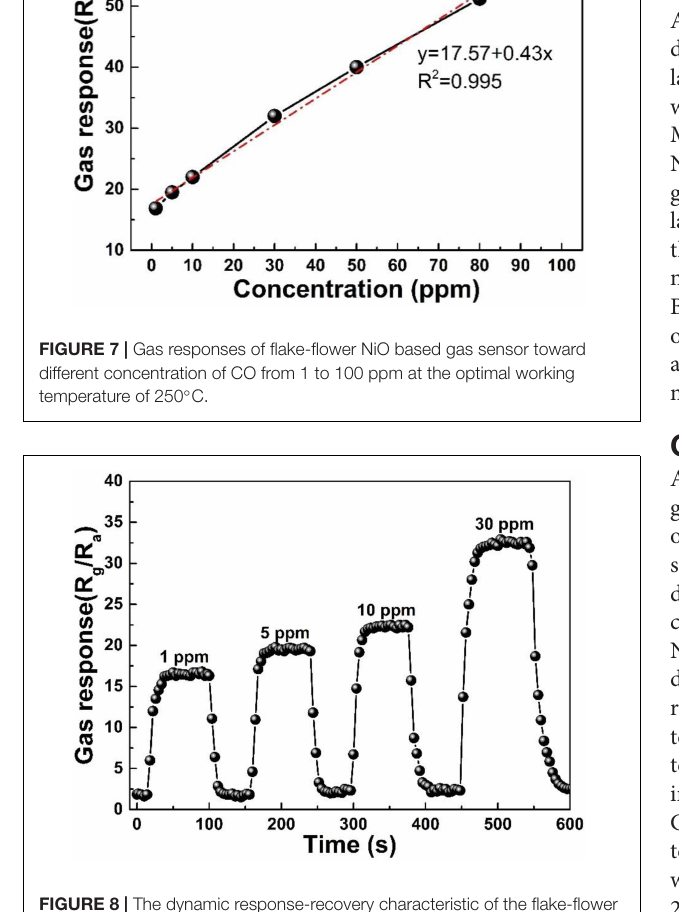
FIGURE 8 | The dynamic response-recovery characteristic of the flake-flower NiO based gas sensor toward different concentration of CO (1, 5, 10, 30 ppm) at 250 ◦